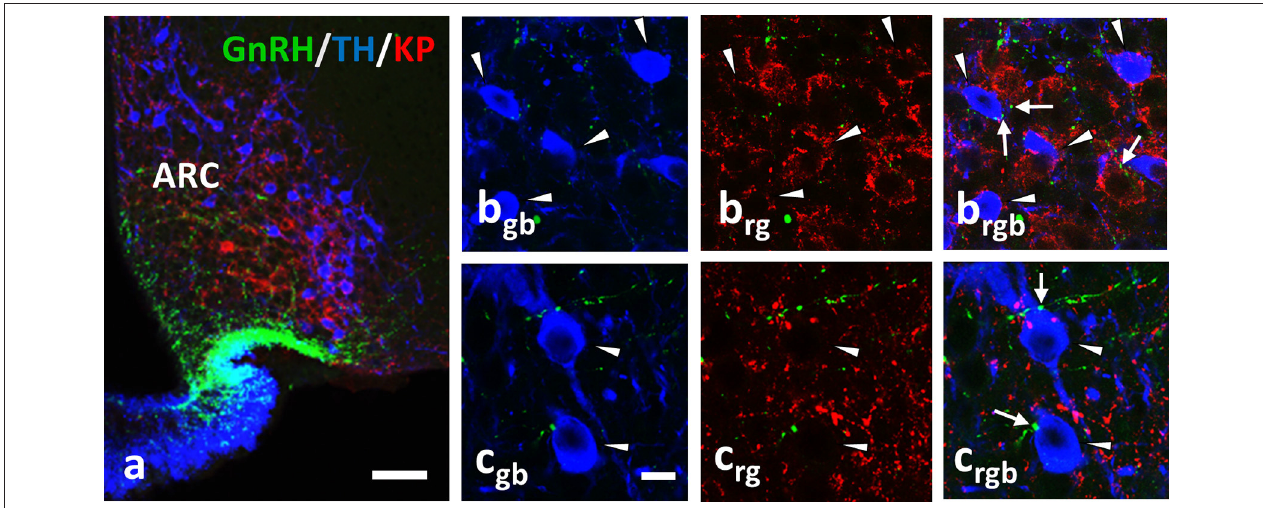
FIGURE 4 | Immunohistochemical triple labeling for GnRH (green), TH (blue) and KP (red) in the Arc, where TH neurons are not immunoreactive for KP (a) ; TH- and KP-IR neurons form two separate populations. The TH-IR neurons (arrowheads) receive axo-somatic and axo-dendritic appositions from GnRH-IR fibers (arrows; b,c ). rgb; red-green-blue channels. Scale bar in (a) is 50 µ m; in (b gb -c rgb ) 10 µ